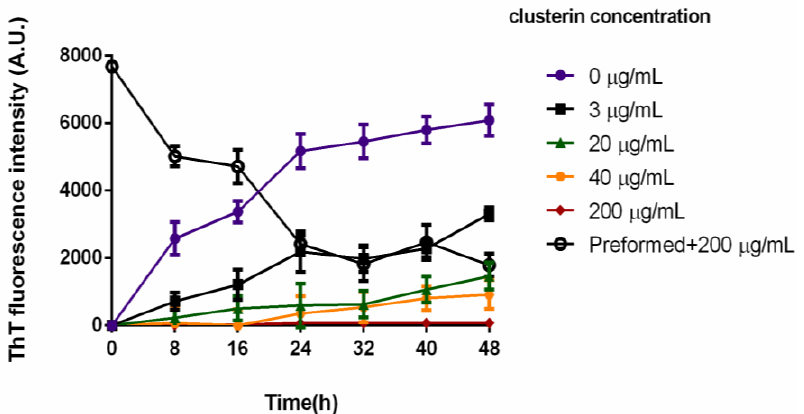
Figure 1. Amyloid fibril formation of 2 mg/mL PAP248–286 peptide (439 µ M) with varying concentrations of clusterin (0.050, 0.333, 0.666 and 3.33 µ M clusterin monomer, and hence molar ratios of PAP248–286:clusterin monomer of 8788:1, 1318:1, 659:1 and 132:1 respectively) upon incubation for two days at 37 ◦ C and pH 7.2. Also plotted are the results of an experiment in which 2 mg/mL solution of preformed SEVI fibrils was incubated under the same conditions with 200 µ g/mL clusterin (3.33 µ M). The data shown are means ± SD of triplicates. Some error bars are smaller than the size of the individual data points. Clusterin does not bind ThT in its native state, nor does it form amyloid fibrils in vitro under physiological conditions, and over the time course of this experiment [29].